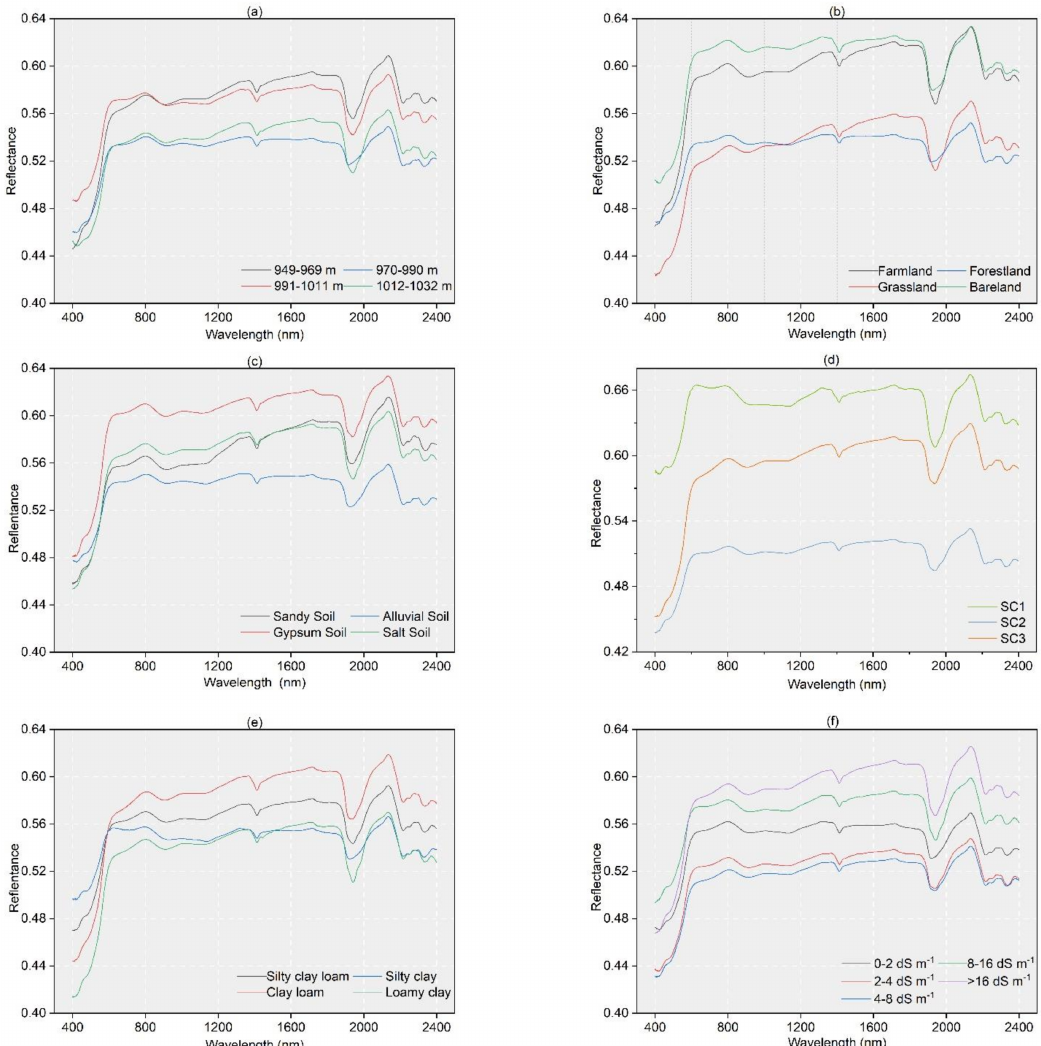
Figure 3. Spectral reflectance data with different auxiliary variables; ( a ) DEM, ( b ) LULC, ( c ) soil texture, ( d ) spectral classification, ( e ) WRB, and ( f )